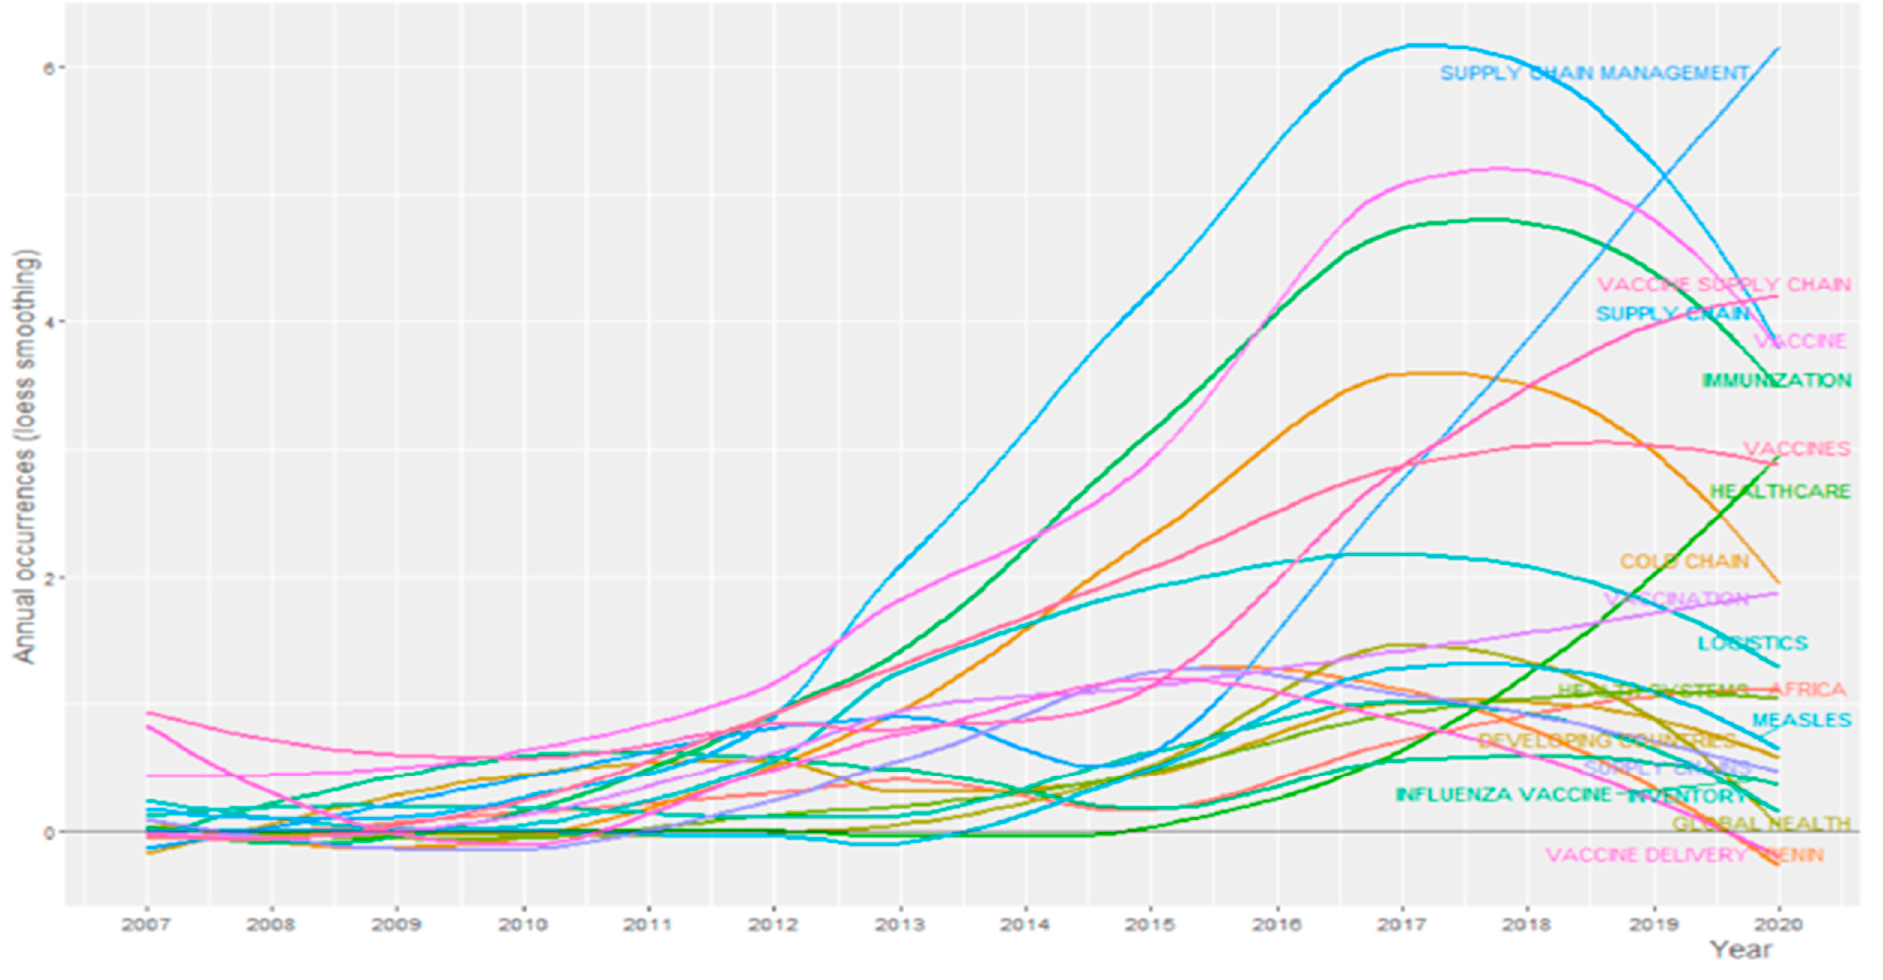
Figure 12. Word growth.